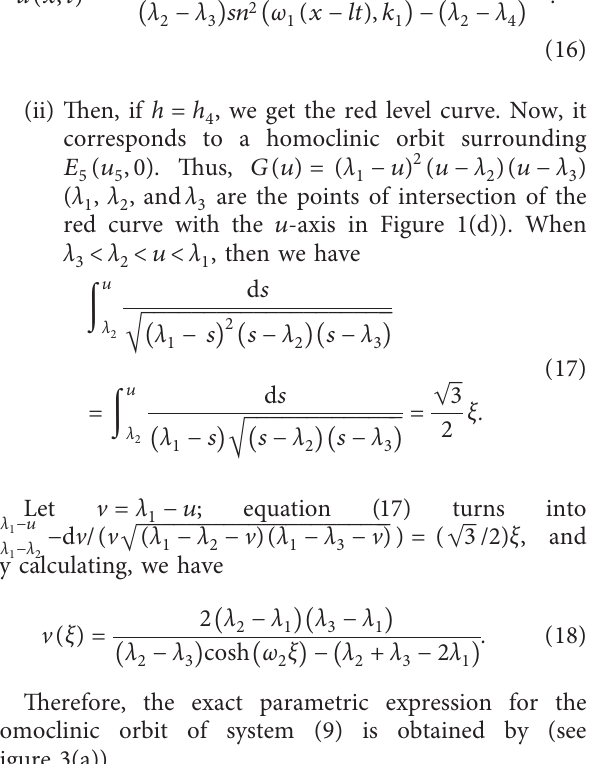
� √ 3 . (a) Periodic wave. (b) Exact periodic wave